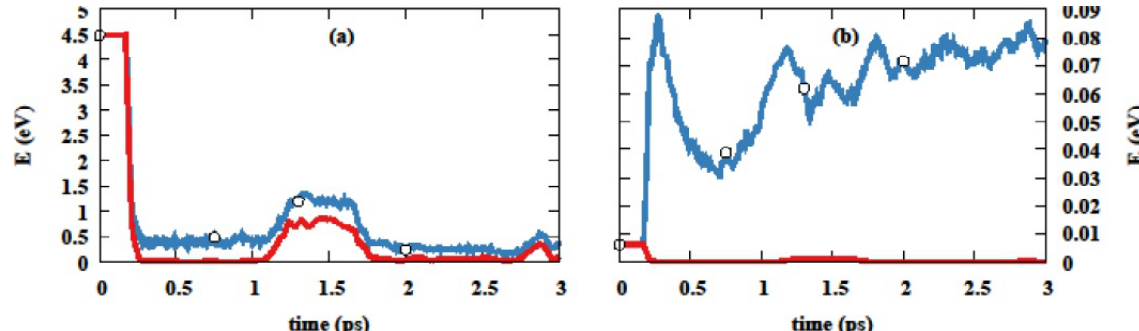
Fig. 7. Same as in Fig. 3 but for V from Fig.